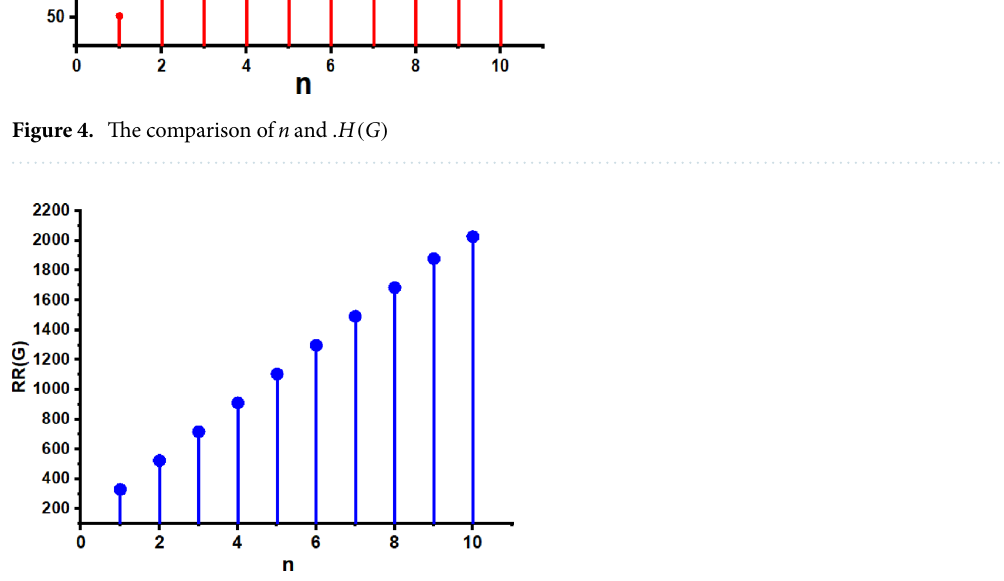
Figure 5. The comparison of n and . RR ( G )